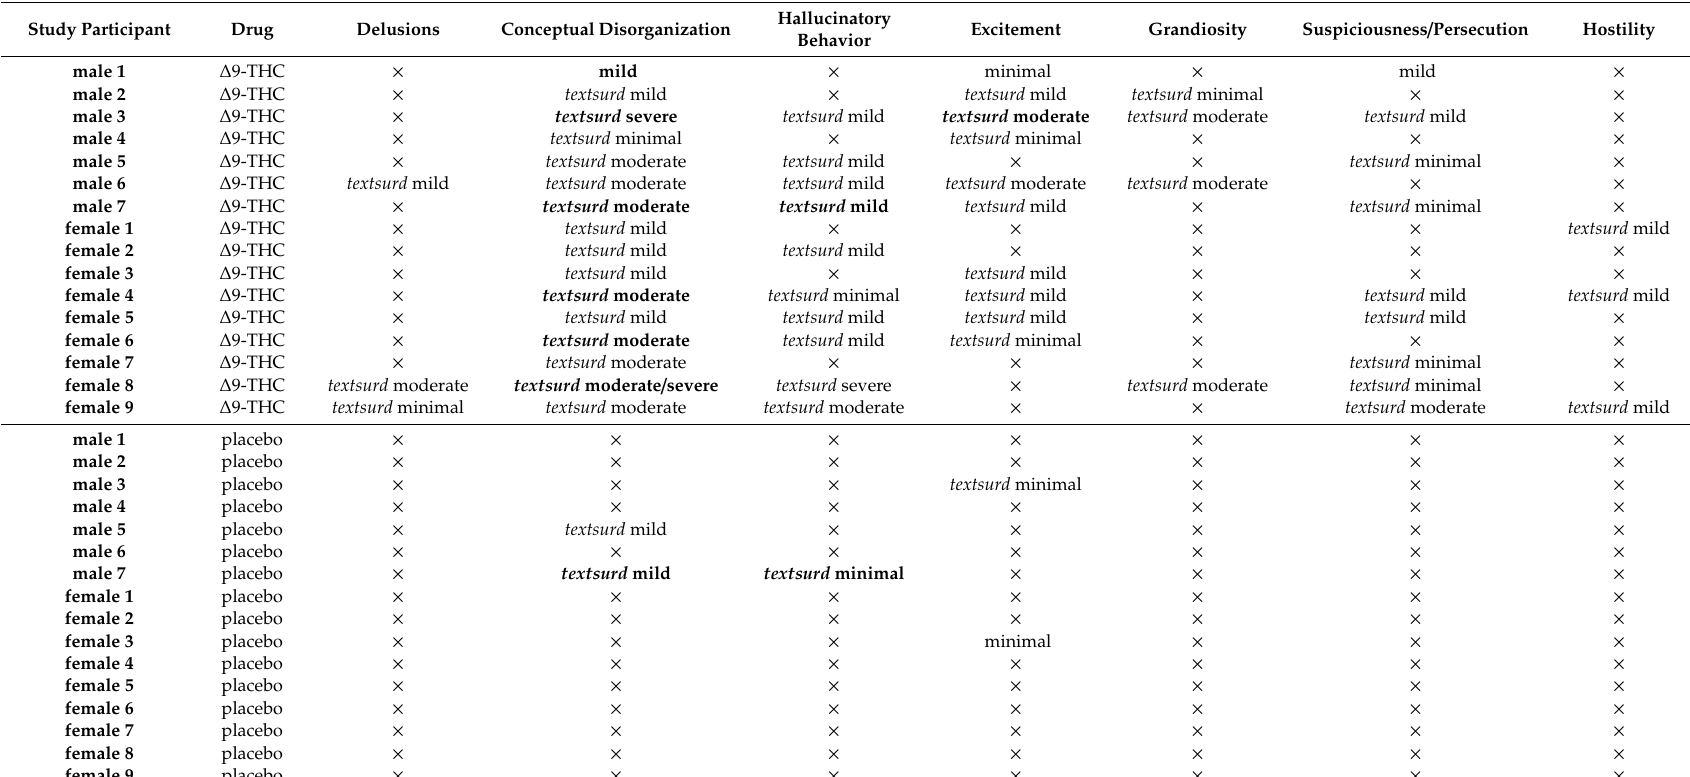
Table 1. Psychosis-related positive symptoms and